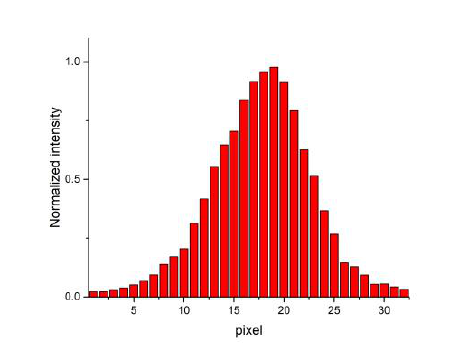
Fig. 5. The RBS spectrum of CO2 at pressure 3.00 bar, temperature 293.0